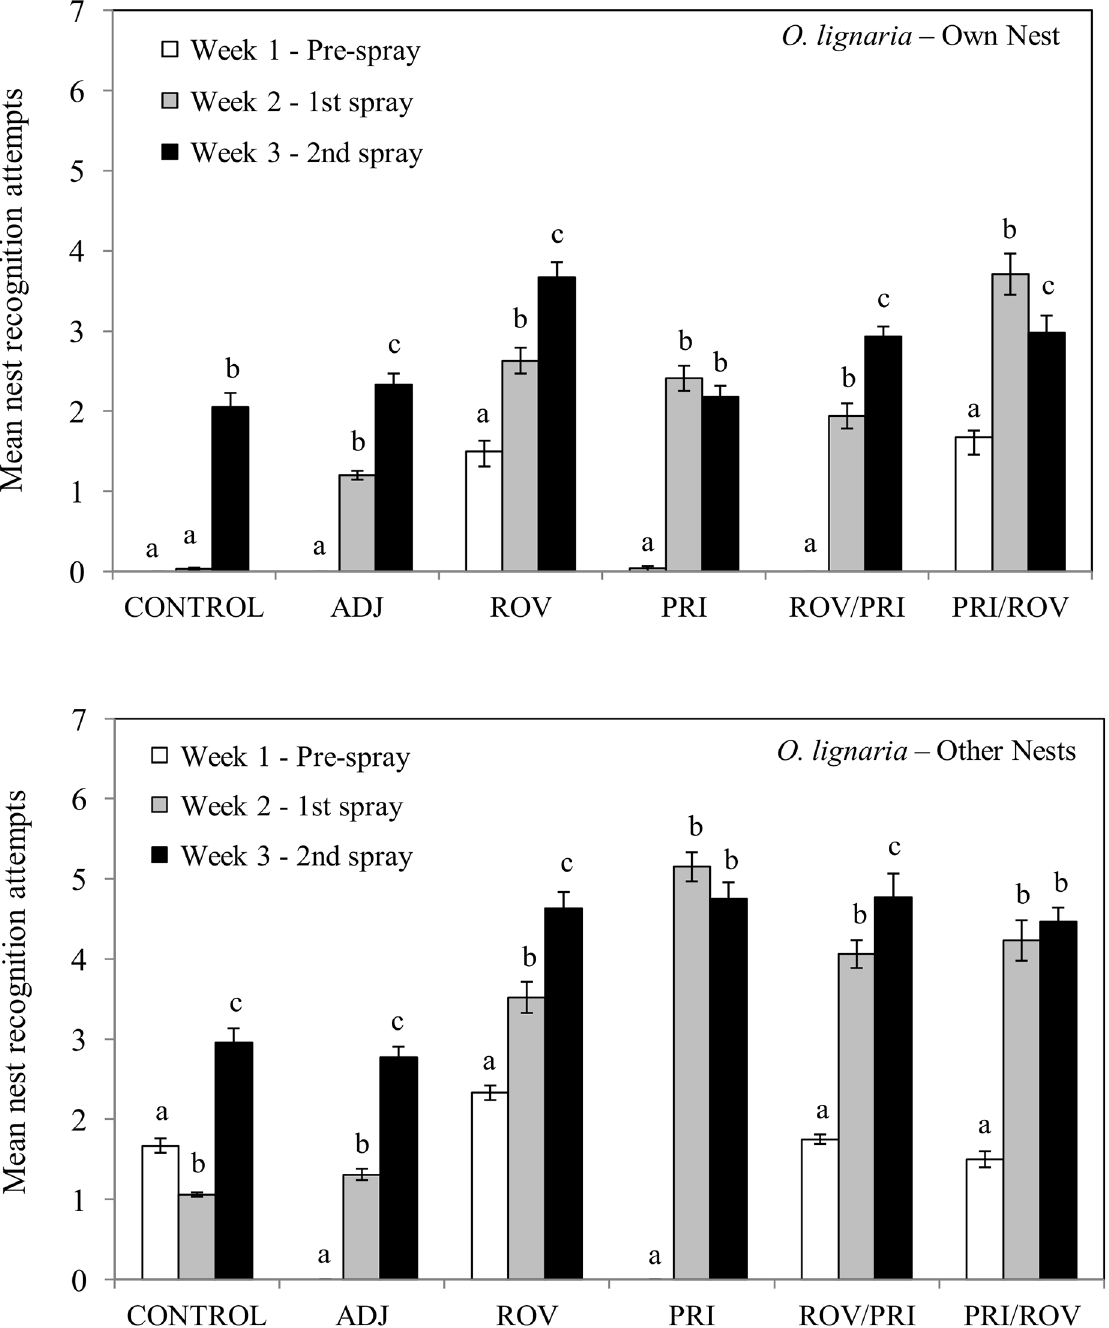
Fig 2. Mean attempts to enter her nest and other nests by Osmia lignaria females before and after treatment applications. Means within each treatment with different letters are significantly different ( P <